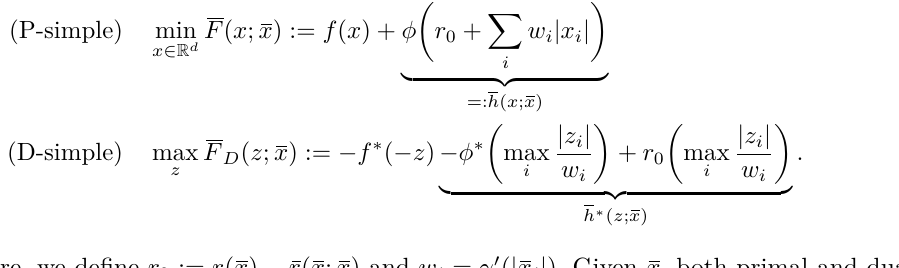
Figure 1 Transformations φ and γ . Left: Level sets for the penalty h ( x ) = φ ( P concave penalty γ increases the “spike-ness”; the convex penalty φ increases the effect of the aggregate value. Right: Three example functions of γ . RP-CGM will behave erratically when γ min = 0 (red and blue) and γ max is unbounded (red), so we use a penalty that is bounded on both ends (green = concave +